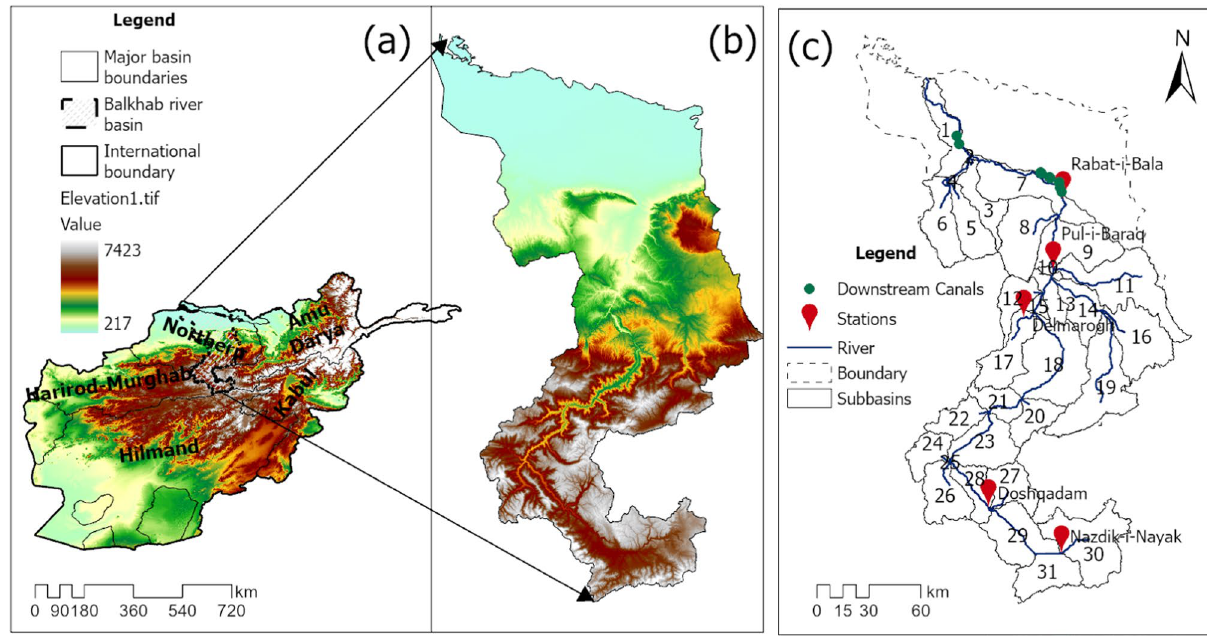
Fig. 1 Map of the study area: a Afghanistan map showing the five major basins and elevation, b Balkhab River basin (BRB) with the Balkhab River, five hydrometeorological stations, and eleven irrigation canal downstream